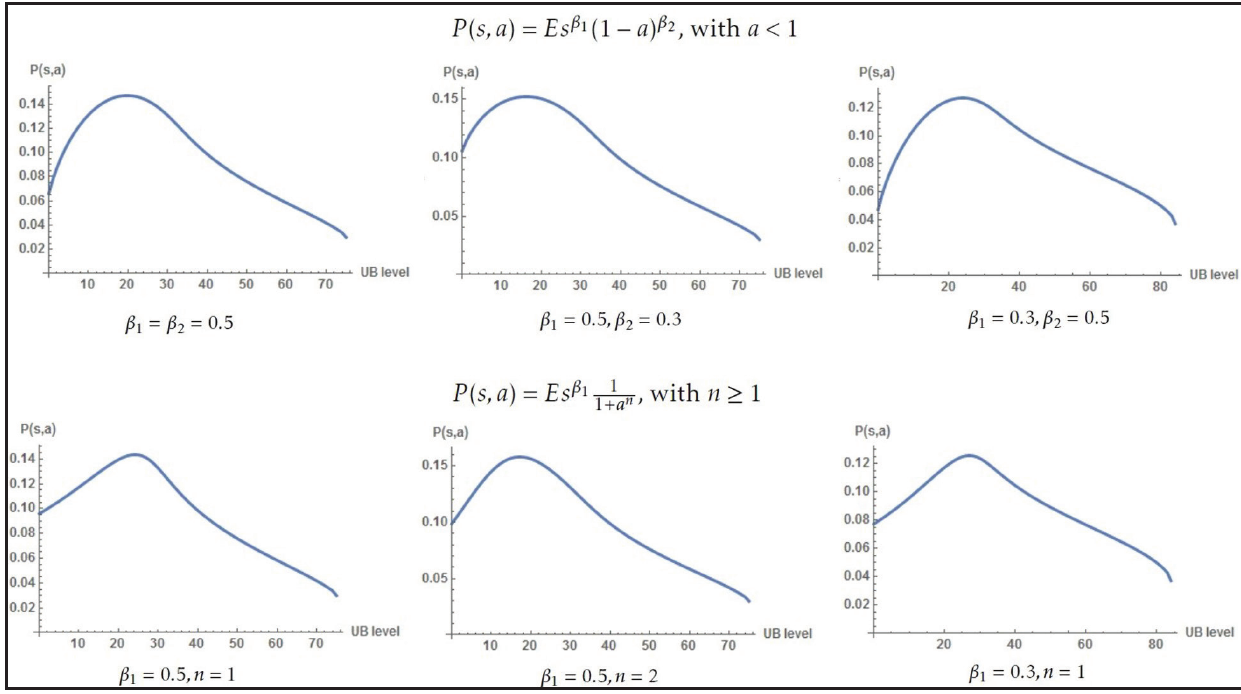
Figure 3 These graphs show the shape of the job-finding probability P ( s , a ) for different values of b respectively. The other functions and parameters are those of Table